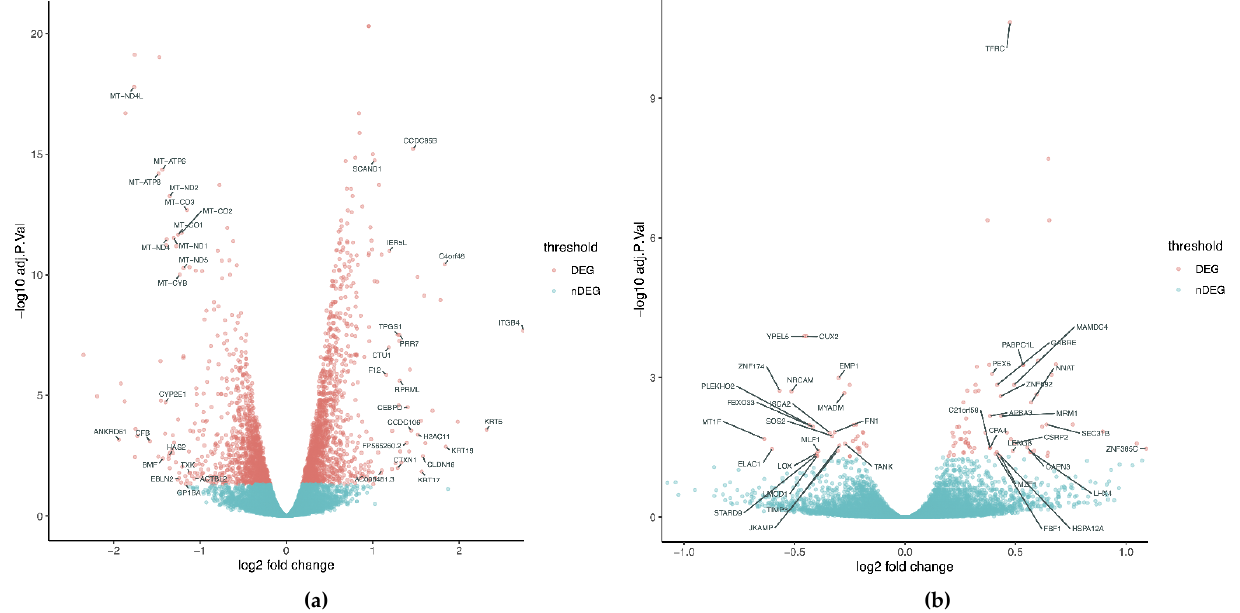
Figure 4. Volcano plot representation of the main genes whose expression significantly changed under hyperoxic conditions in ( a ) uveal melanoma cell line (MUM2B) and ( b ) normal human bronchial epithelial cells (HBEC3-KT) (Figure S1).